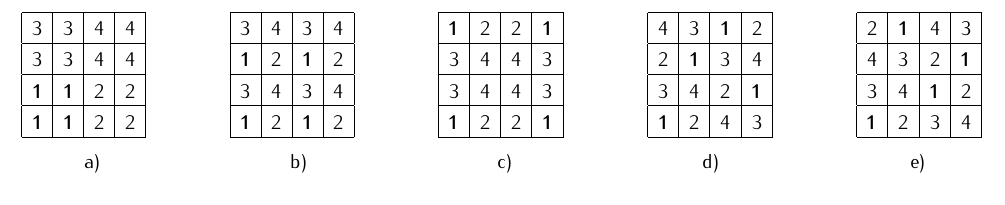
Figure 4. A complete set of mutually orthogonal supersquares of order d) and e) are